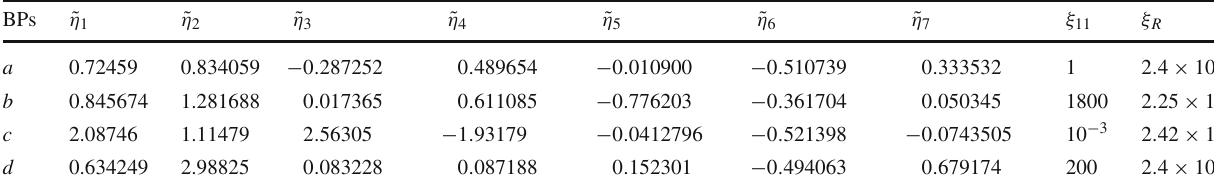
Table 1 Benchmark points chosen for our analysis. See text for details